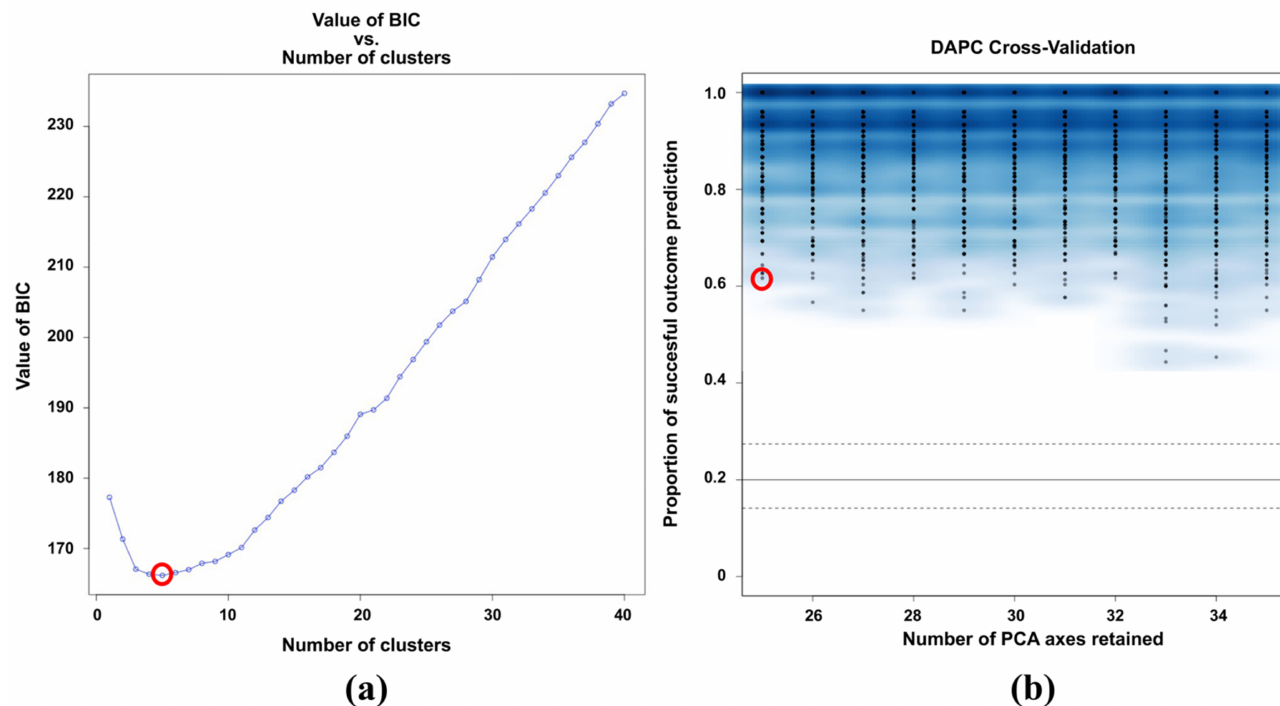
Figure 2. Clustering and DAPC cross-validation. ( a ) Inference of the optimal number of clusters in the 115 interspecific plum × apricot hybrids and 27 reference genotypes (diploid plums and apricots), and ( b ) DAPC cross-validation for the optimal number of principal components (PCs) retained for the analysis in the five predefined